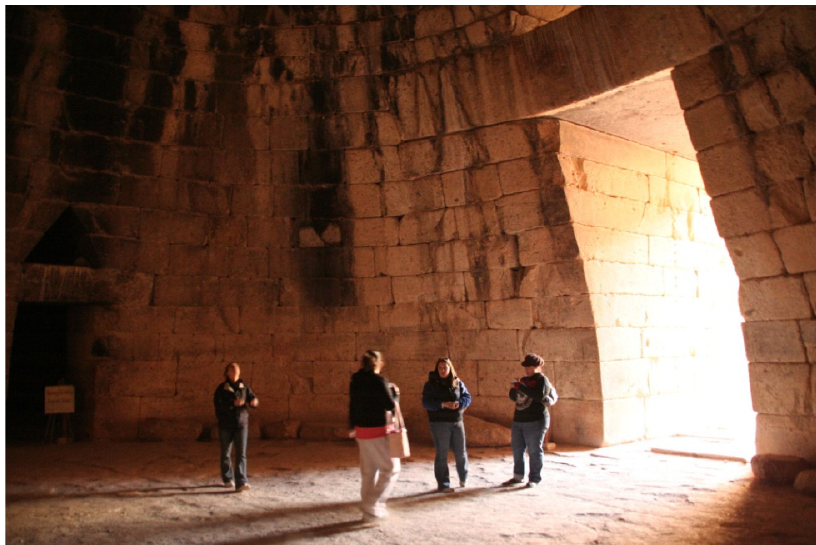
Figure 5. Interior of the Treasury of Atreus, near the entrance.